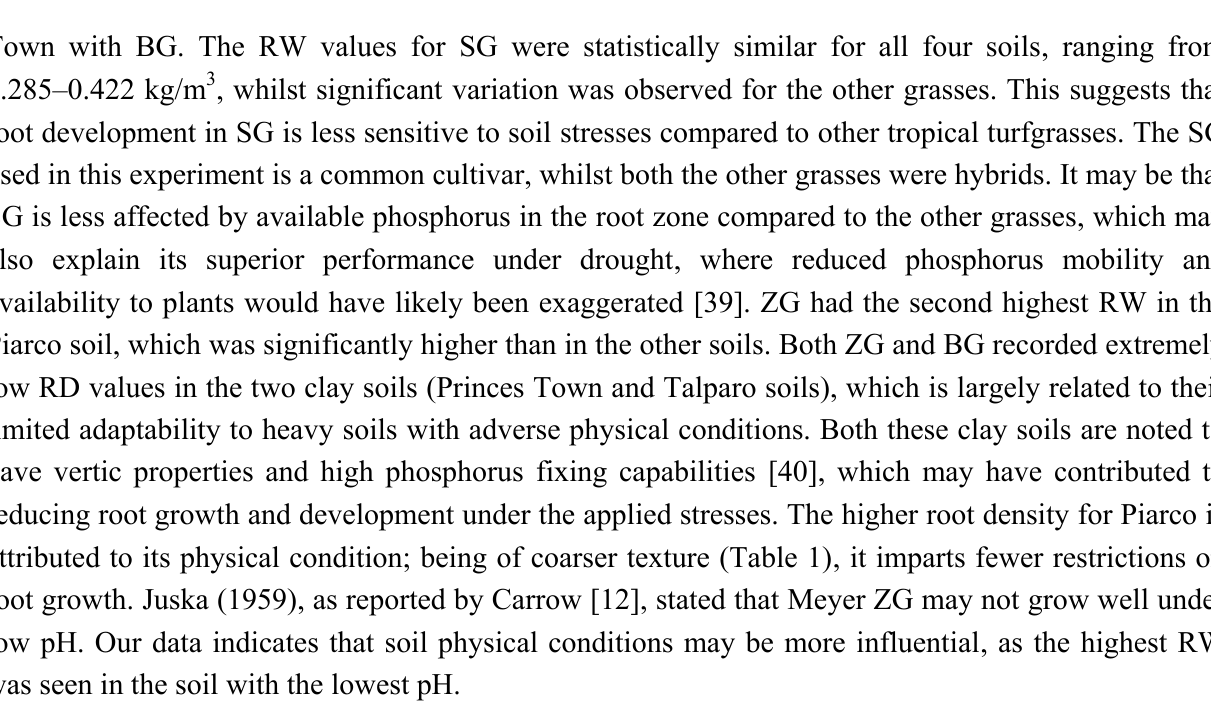
Table 4. Root weight for three turfgrasses planted in four